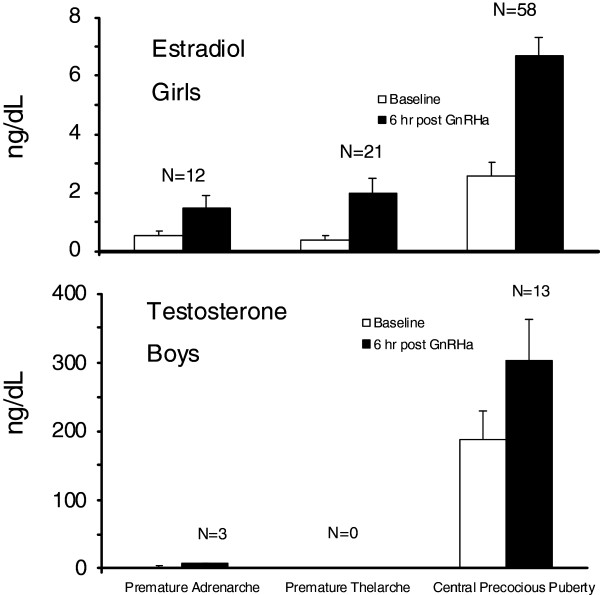
Baseline and peak stimulated serum Estradiol (upper panel) and Testosterone (lower panel) concentrations (mean ± SEM) at baseline and 6 hours after leuprolide injection. Estradiol and Testosterone concentrations in central precocious puberty were significantly higher than in either the children with premature thelarche or premature adrenarche (P< 0.005).